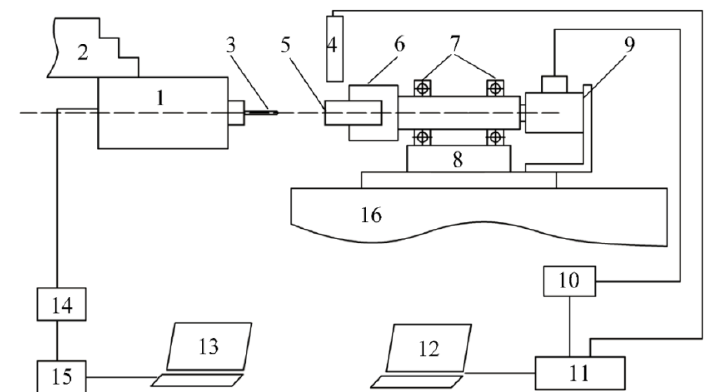
Figure 2. Schema of the experimental tests. 1—Rotary vibration actuator, 2—Lathe chuck, 3—Drill bit, 4—Thermal sensor, 5—Workpiece, 6—fixture, 7—Bearing, 8—Force sensor, 9—Torque sensor, 10— 166